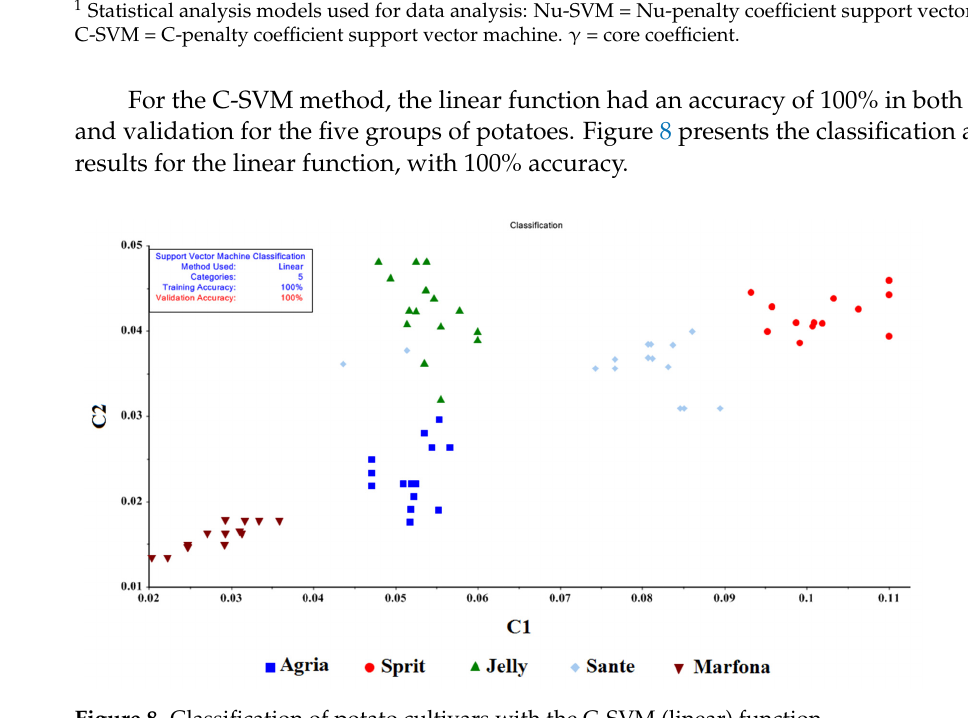
Figure 8. Classification of potato cultivars with the C-SVM (linear)